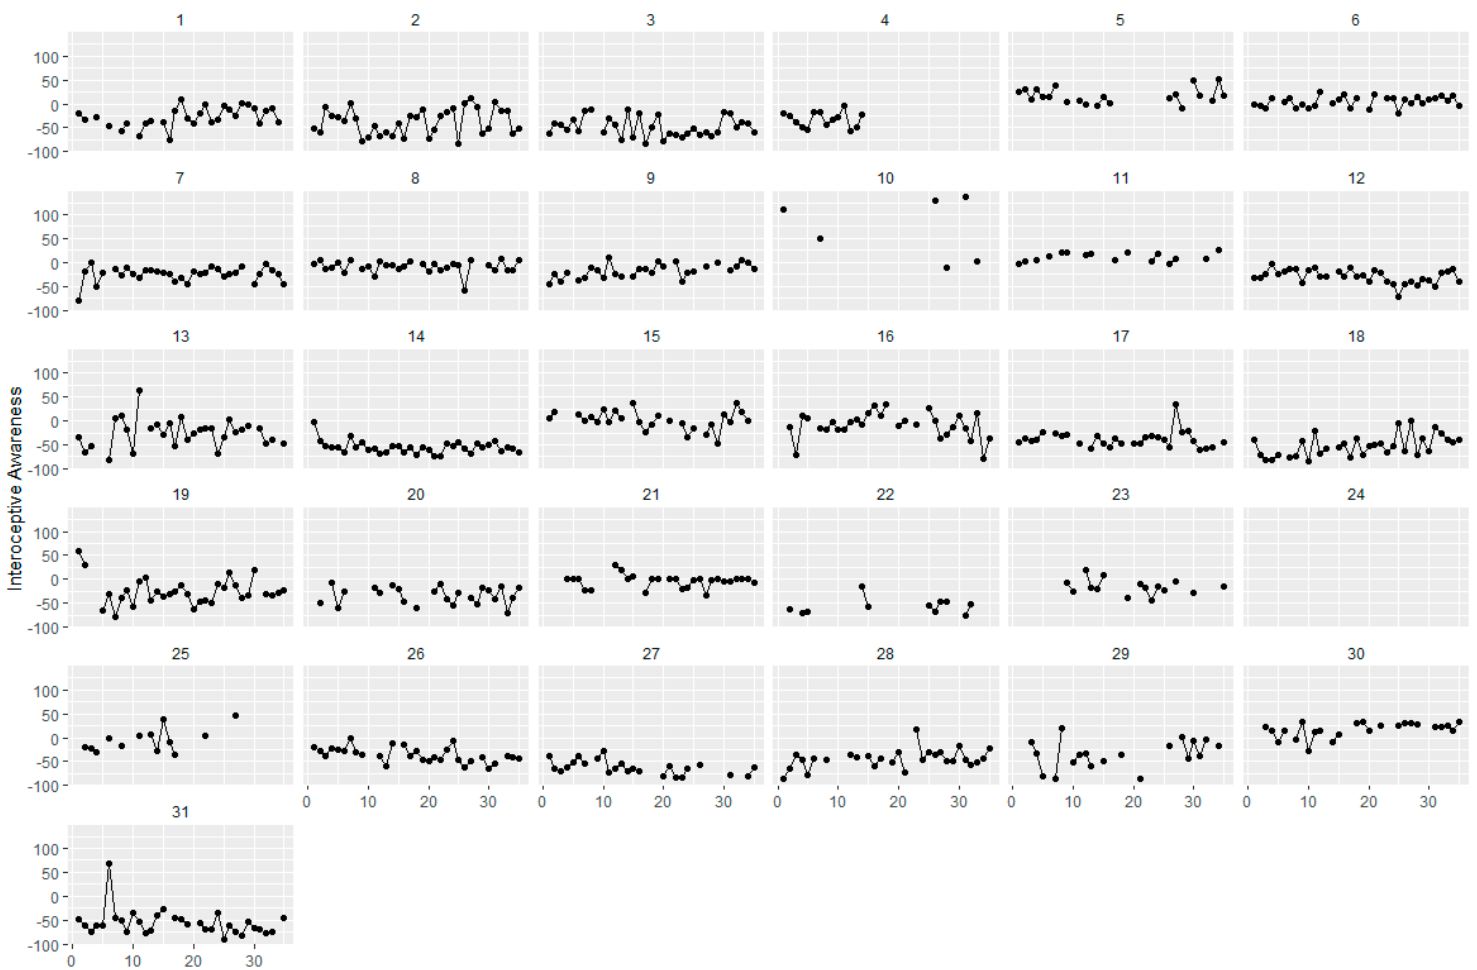
Figure 3. Interoceptive Awareness. Trajectories of interoceptive awareness for each of the 31 participants during EMA. Assessment points range from 1 to 35 over a time period of 7 days, interoceptive awareness ranges from − 100 to 100.